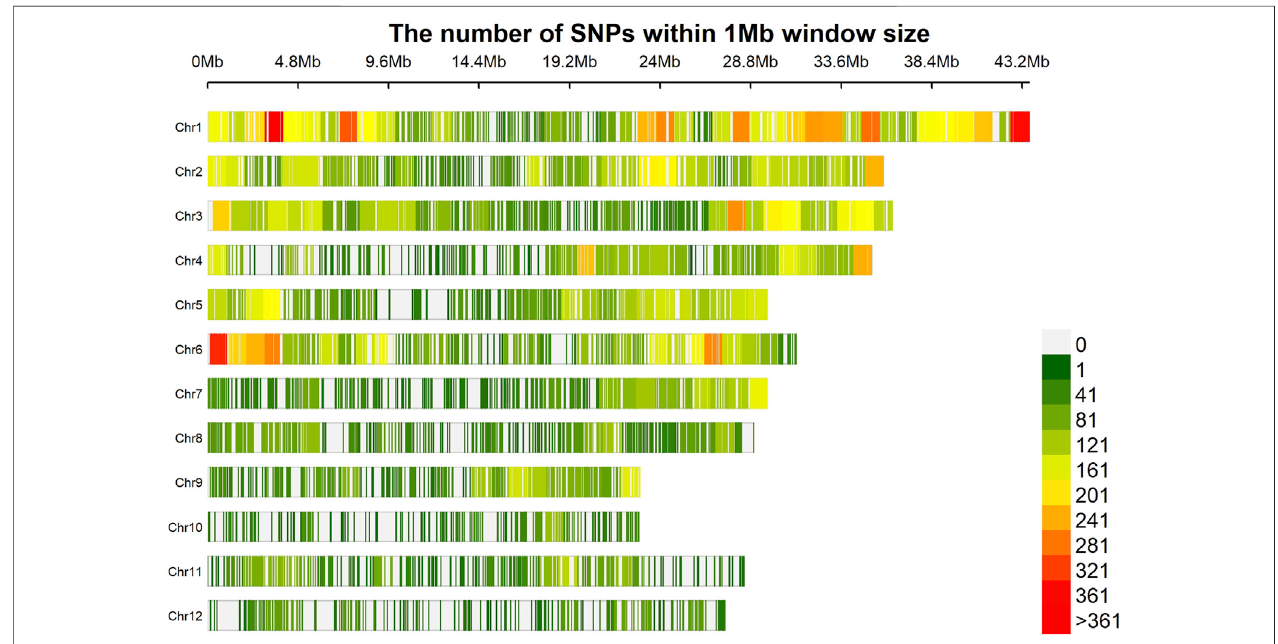
FIGURE 2 | Density of SNP across the genome. The highest coverage can be observed on chromosomes 1 and 6, while the lowest is on chromosome 12.